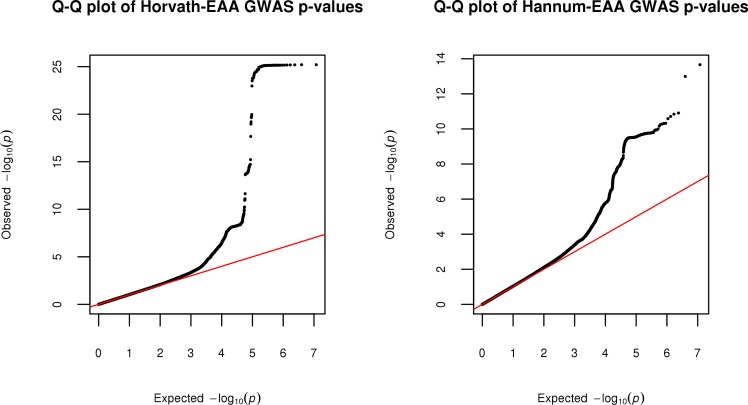
QQ plots for the meta-analyses of Horvath-based and Hannum-based epigenetic age acceleration.Quantile-quantile plots for the genome-wide meta-analyses of Horvath-EAA and Hannum-EAA, showing the expected distribution of GWAS test statistics, -log10(p), versus the observed distribution.